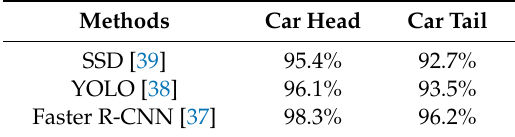
Table 1. Results of different methods for car head and car tail detection.